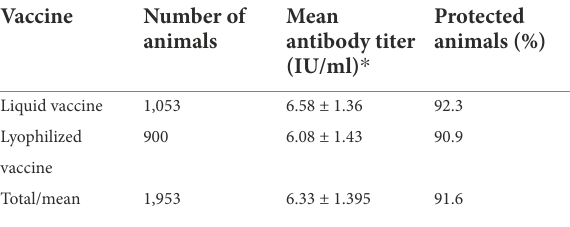
TABLE 3 Immune status of reindeer vaccinated against rabies.